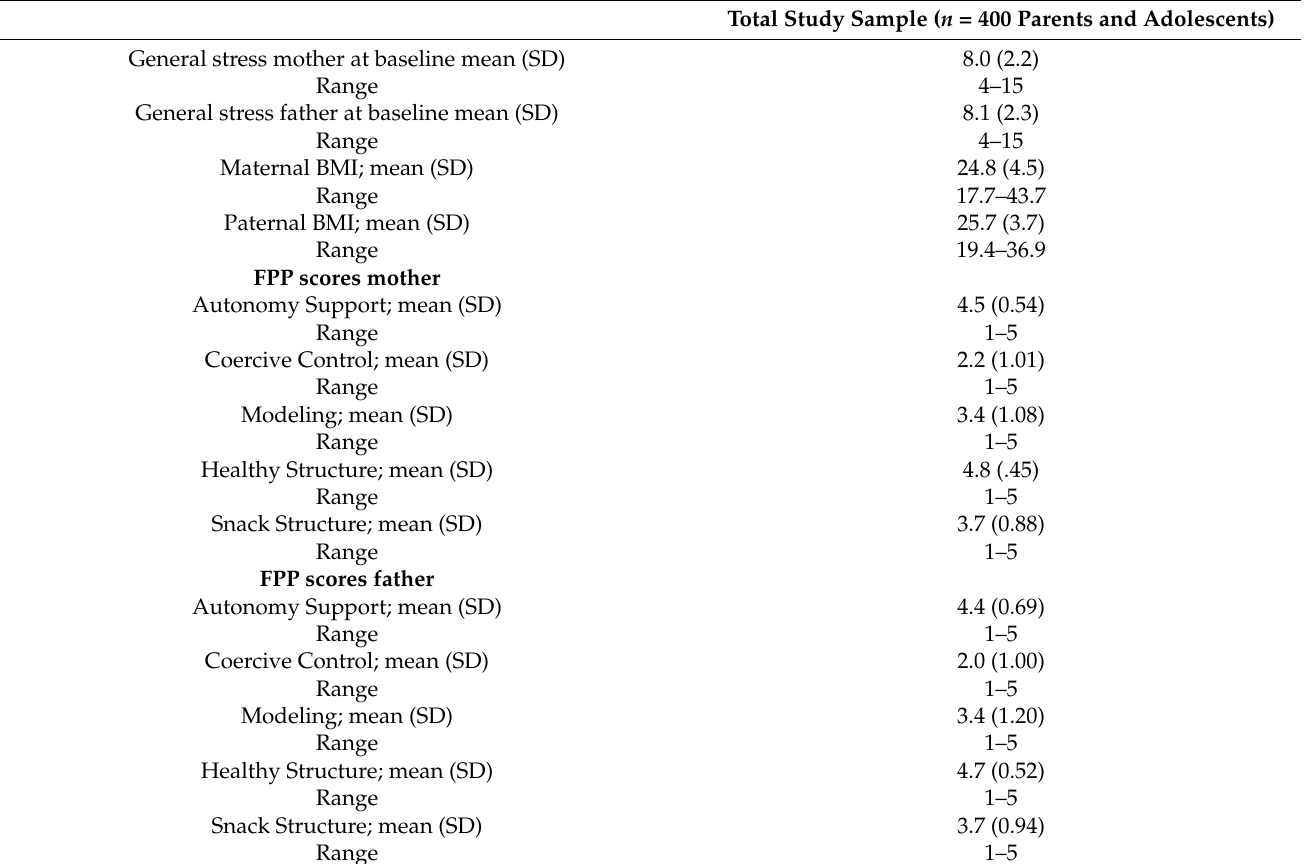
Table 1. Cont . Total Study Sample ( n = 400 Parents and